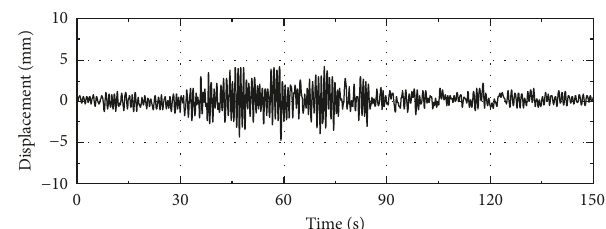
Figure 17: Displacement response curve of intensity 7 frequently of Alaska (longitudinal